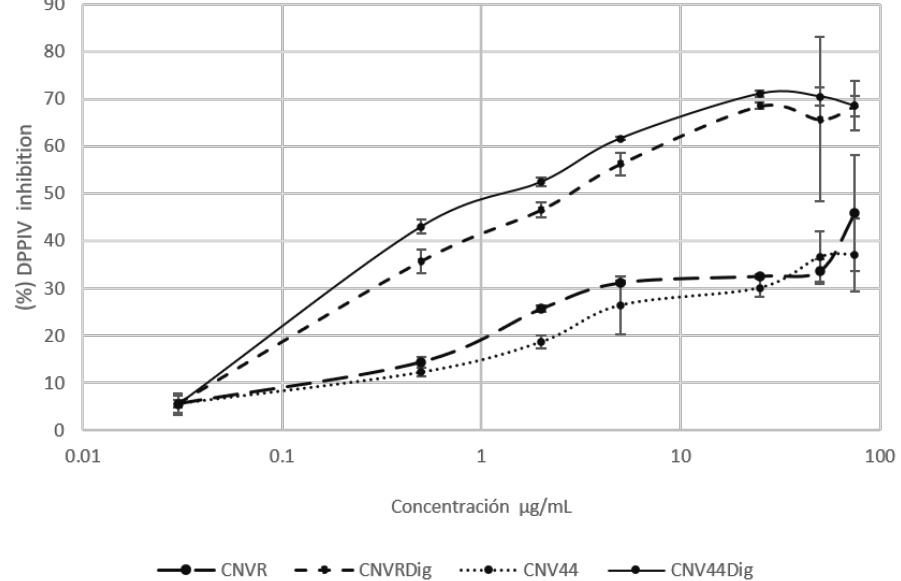
Figure 8. DPPIV inhibitory activity of CNVR and CNV44 and their hydrolysates.